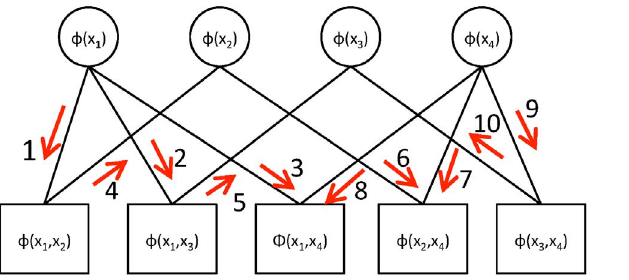
Figure 8. Illustration of a factor graph with message passing. Circles depict singleton factors. Squares depict pair factors. Red arrows and numbers indicate a possible message passing schedule.